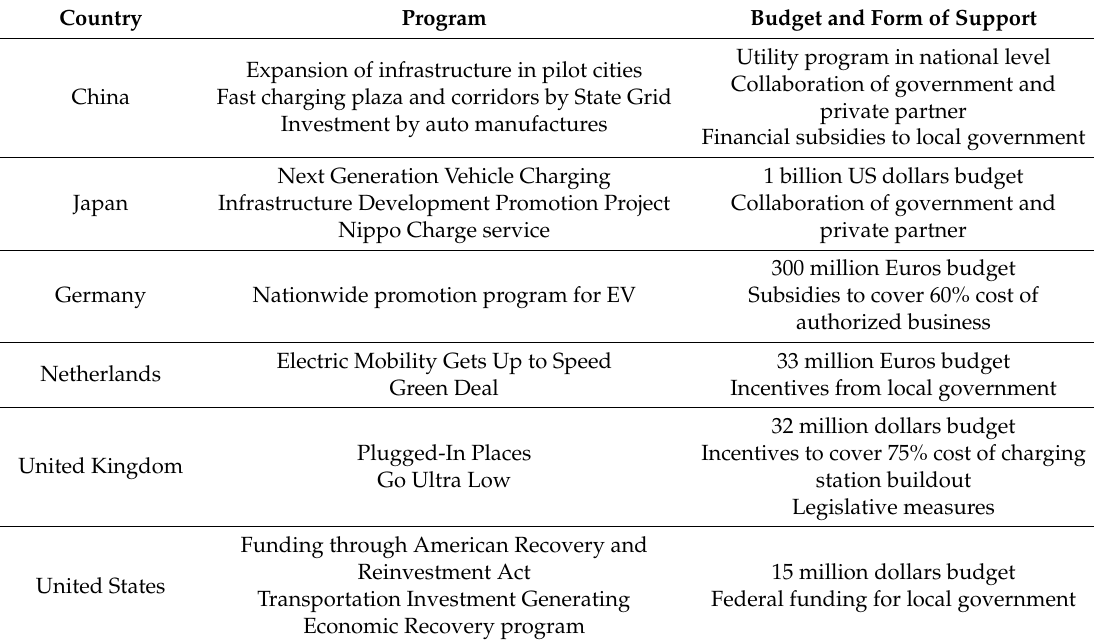
Table 4. Summary of major charging infrastructure programs in several